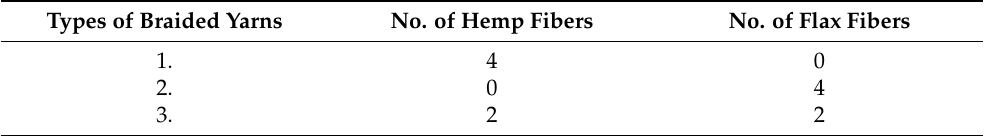
Figure 2. ( a ) Optical microscopy image of braided flax fibers, ( b ) schematic view of fibers representing diamond braid (1/1). Table 1. Different types of braided